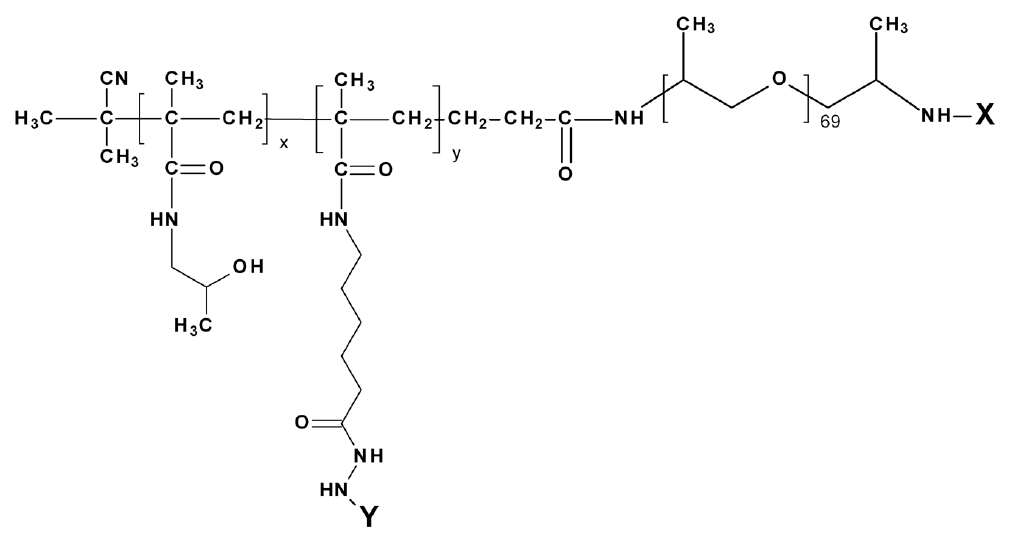
Figure 1. The schematic structure of amphiphilic block copolymers based on PHPMA and PPO: (X) = H, diblock copolymer; (X) = PHPMA, triblock copolymer; (Y) = Boc, Boc-protected copolymer; (Y) = H, deprotected copolymer with free NHNH 2 groups.